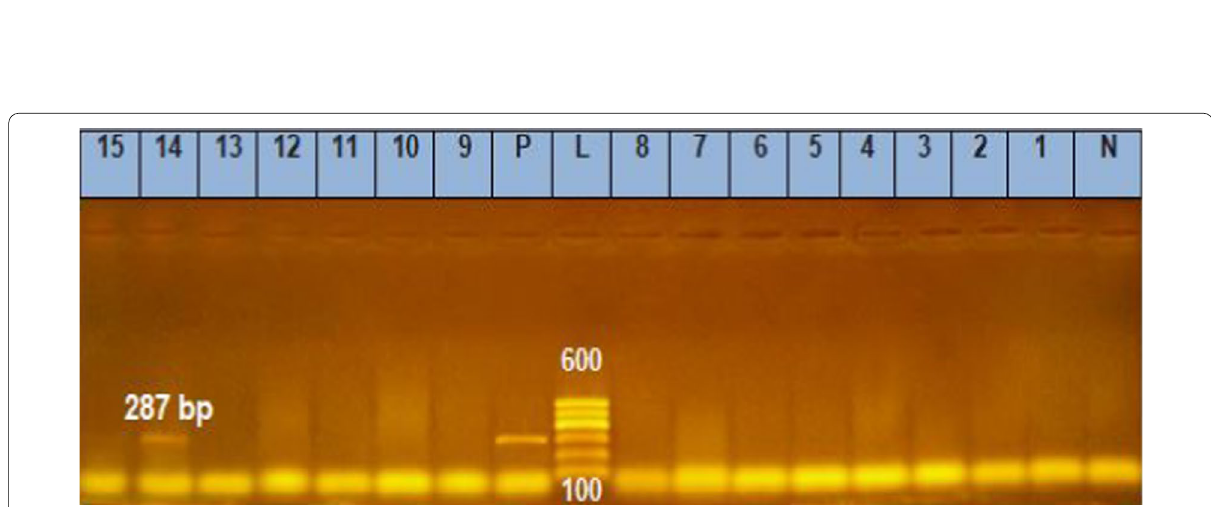
Fig. 9 Agarose gel electrophoresis showing amplification product of 287 bp of NDM-1 . Lane L : Ladder (Marker) 100‑1000 bp plus DNA ladder. Lane P: control positive. Lane N : control negative. Lane 1–15 : examined isolates